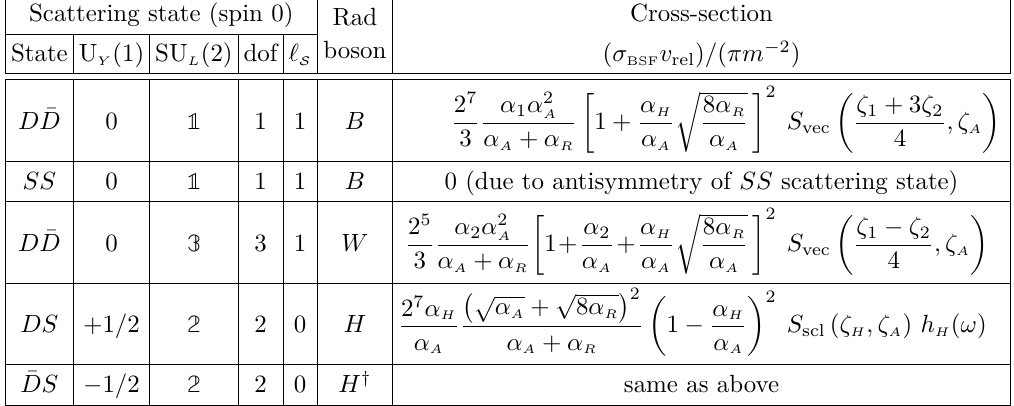
Table 7 . Radiative processes and cross-sections for capture into the ground level of the SS/D bound states. Here, α averaged over the dof of the corresponding scattering state (4th column). S in eqs. (3.6), and h